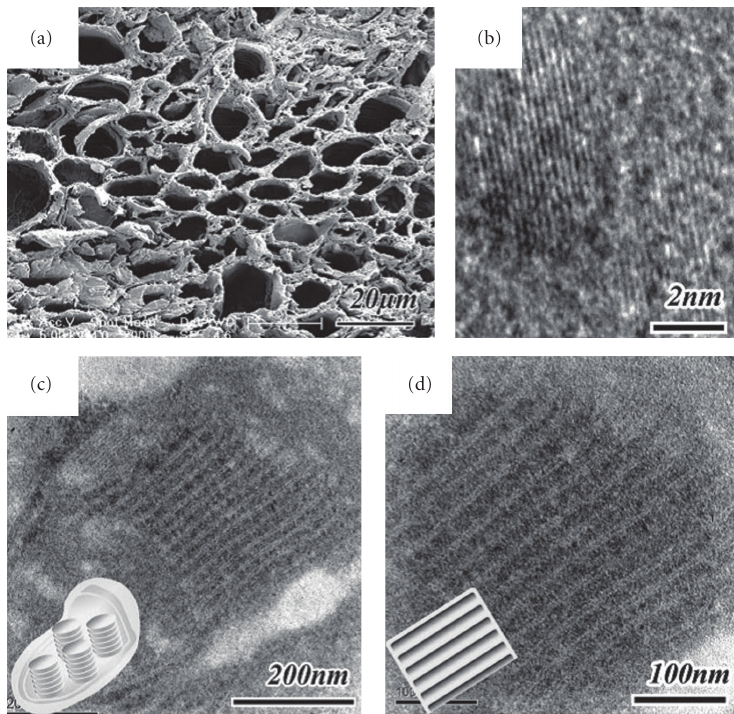
Figure 3: (a) SEM image of a cross-section of AIL-TiO 2 derived from A. vitifolia Buch. leaf. ((b), (c)) TEM images of a layered nanostructure in AIL1-TiO 2 , with a corresponding illustration of the 3D structures. (d) TEM image of Pt nanoparticles deposited on TiO 2 [57].